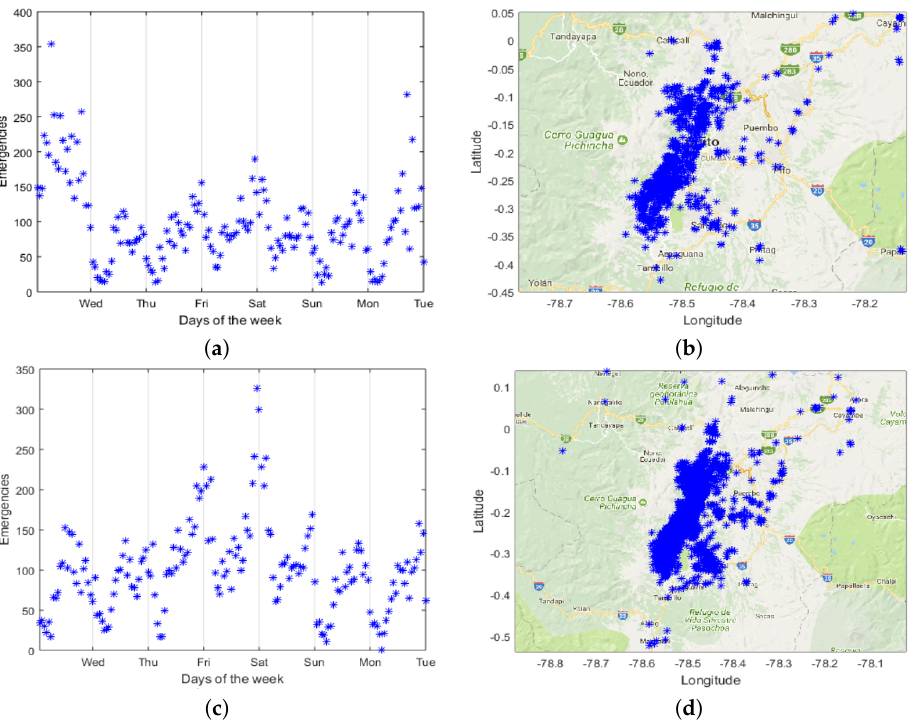
Figure 2. Emergencies registered during January, 2014. Number of events as a function of time during the first and third weeks ( a , c ); grouped by hours, and their scatterplots ( b , d